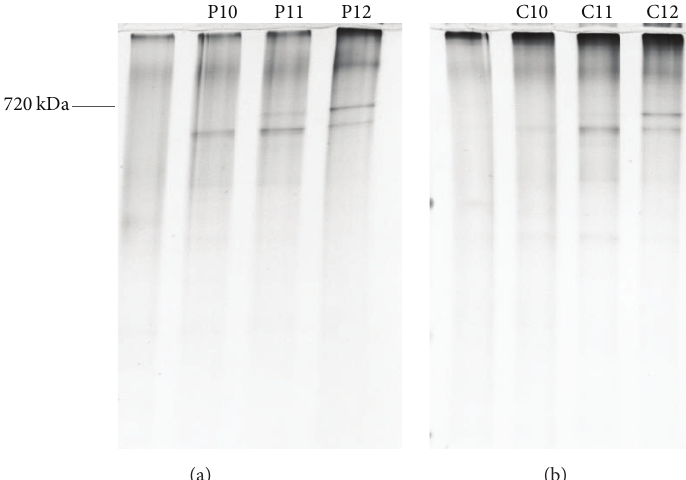
Figure 2: Comparison of distribution of mitochondrial complex V in three adjacent aliquots (sucrose density 34–43%) by BN-PAGE. (a) BN-PAGE results of aliquots fractionated by pipetting method. (b) BN-PAGE results of aliquots fractionated by F-S method.